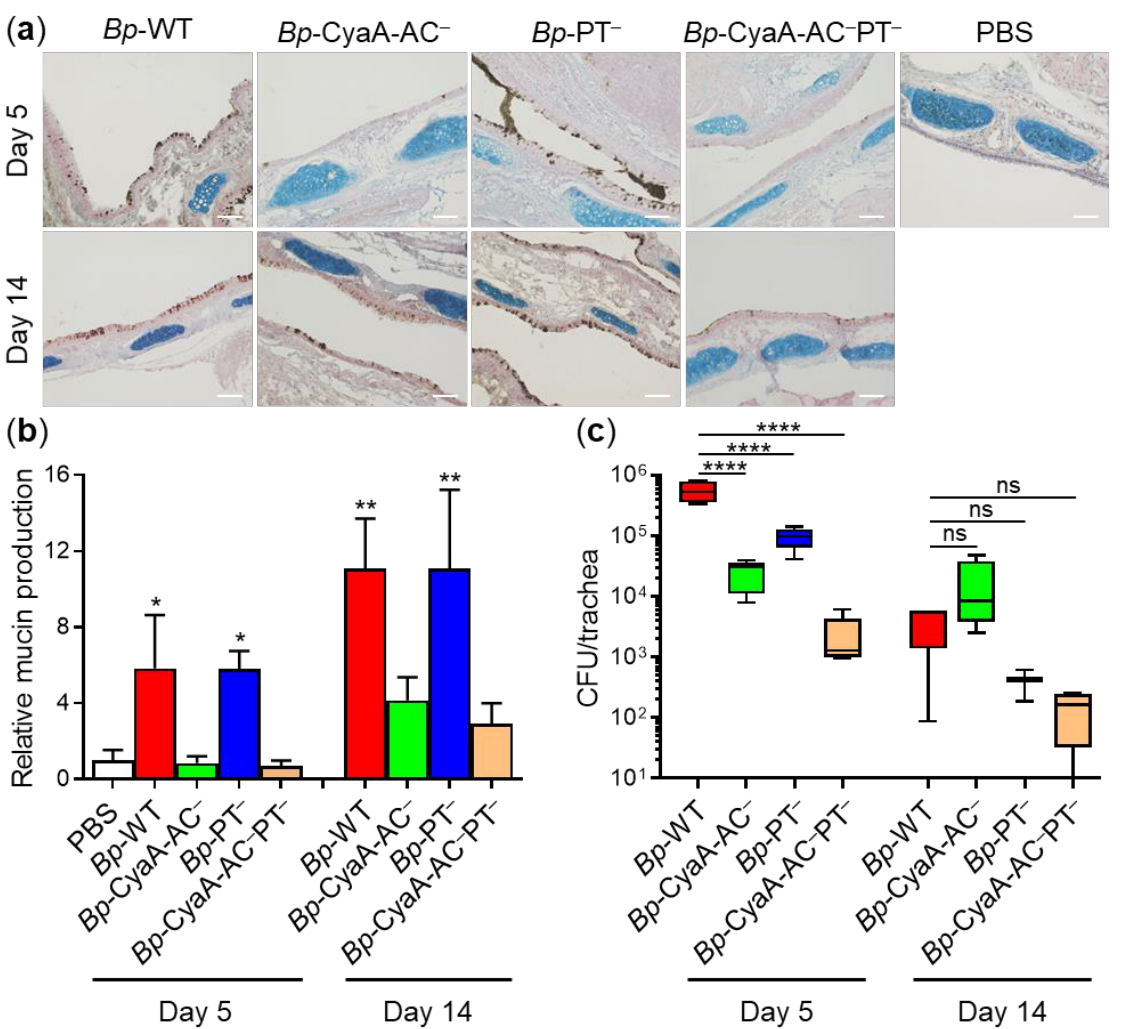
Figure 5. B. pertussis -secreted CyaA alone triggers mucin production in infected mouse tracheas in vivo. Specific pathogen- free BALB/cByJ mice were intranasally infected with 50 µL of suspensions containing ~8 × 10 5 CFU/mouse of the parental strain Bp -WT, or of the isogenic mutant strains Bp- CyaA-AC – , Bp- PT – and Bp- CyaA-AC – PT – , respectively. Animals were sacrificed on day 5 or 14 by cervical dislocation. Tracheas were aseptically removed, fixed with 4% PFA and upon embedding and antigen retrieval, the immunohistochemical staining of histological sections for Muc5AC was performed followed by Alcian blue staining of acidic mucopolysaccharides and sialomucins. ( a ) Tracheas with stained mucins were visualized by light microscopy and representative images are shown. Scale bars, 100 μm. ( b ) Tracheas were scanned using an automated slide scanner and the amounts of tracheal mucins were quantified using the QuPath software. Bars represent means with SEM of relative mucin amounts from two independent experiments (4 – 5 tracheas in each group on day 5; 2 – 5 tracheas on day 14). The mean amount of mucin in tracheas of uninfected animals (PBS) on day 5 was taken as 1. *, p < 0.05; **, p < 0.01 compared with PBS-treated animals. ( c ) Tracheal colonization was quantified by plating serially diluted homogenates of aseptically extracted tracheas (5 tracheas in each group on day 5; 4 tracheas on day 14) on Bordet-Gengou agar plates and B. pertussis CFUs were counted after 5 days of colony growth at 37 °C. ****, p < 0.0001; ns, non-significant.